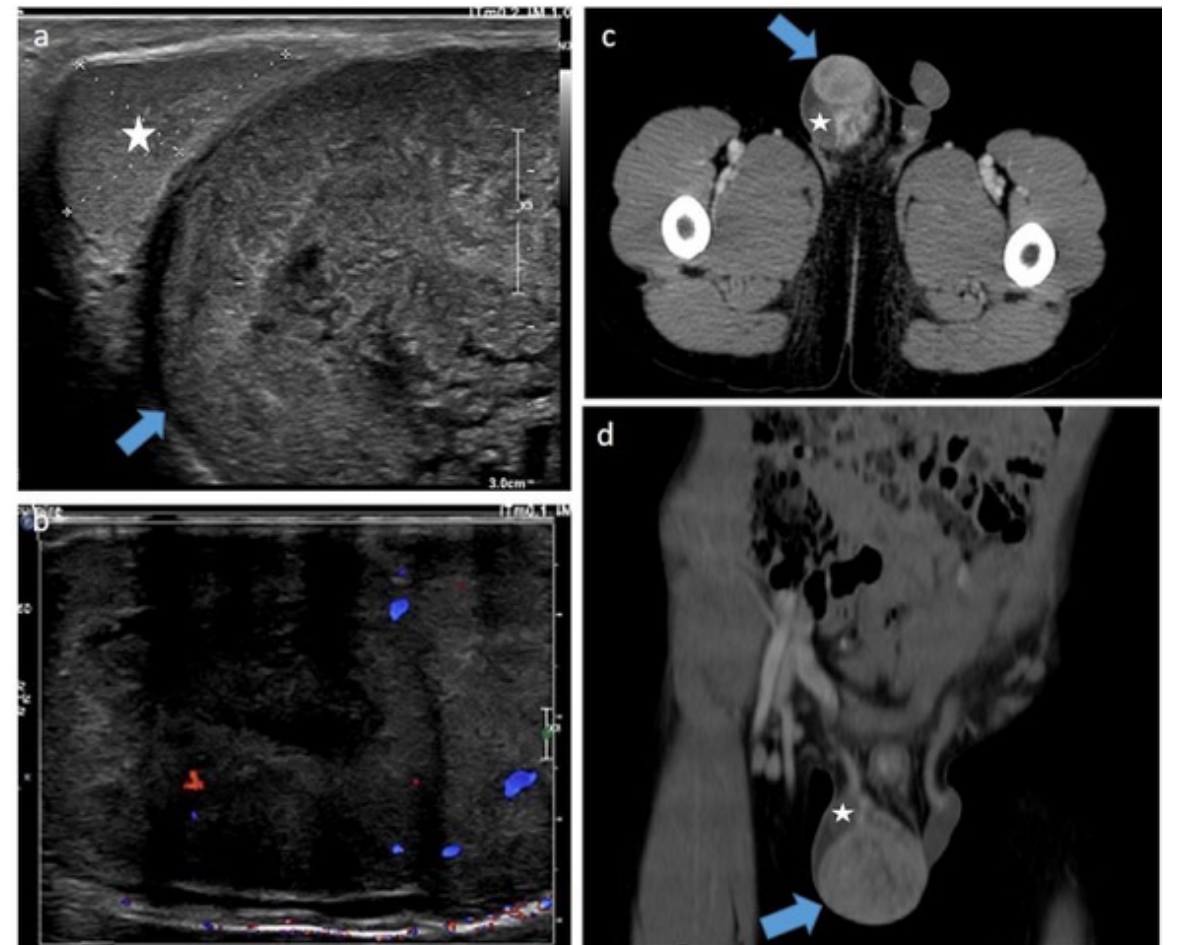
Figure 14. Para-testicular rhabdomyosarcoma in a 6-year-old boy (case 2). Transverse gray-scale B-mode ( a ) and color Doppler ( b ) US of the scrotum. Staging contrast-enhanced CT scan focused on the pelvic on axial ( c ) and coronal ( d ) views. Images show a solid heterogeneous lesion (blue lesion) in an extra-testicular location (testis is represented by a star) with internal vessels on color Doppler images and showing high and heterogeneous enhancement after contrast